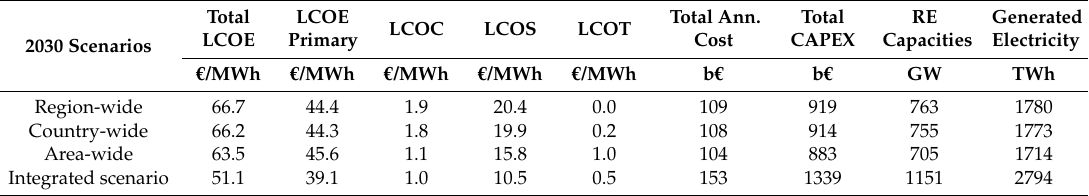
Table 4. Key financial results for the four scenarios applied for Southeast Asian